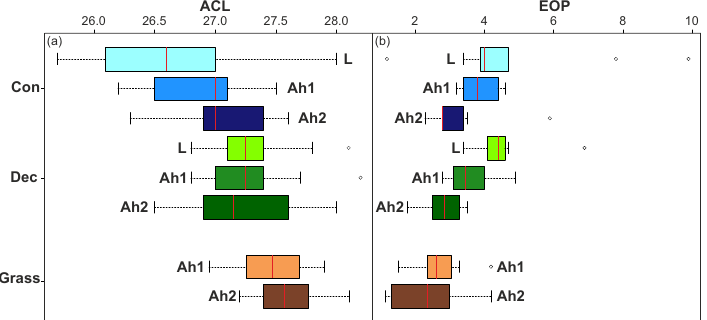
Figure 5. Box plots for (a) n -alkanoic acid ACL and (b) EOP. Con: coniferous forest sites ( n = 9); dec: deciduous forest sites ( n = 14); grass: grassland sites ( n = 14); L: litter; Ah1: topsoil 1 (0–3cm); Ah2: topsoil 2 (3–10cm). Box plots show median (red line), interquartile range (IQR) with upper (75%) and lower (25%) quartiles, lowest datum still within 1.5 × IQR of lower quartile, and highest datum still within 1.5 × IQR of upper